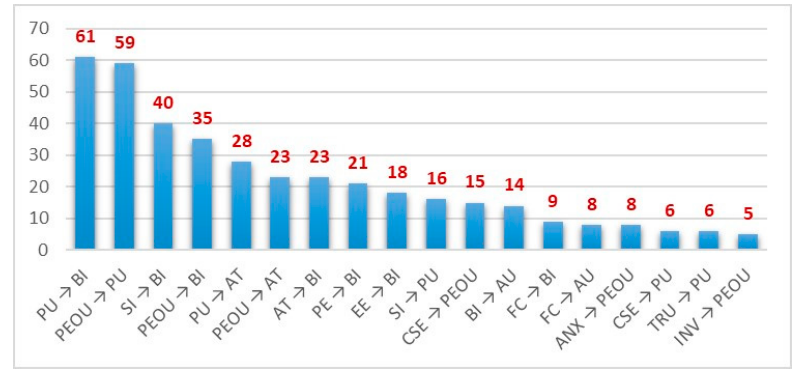
Figure 4. The most confirmed hypotheses in the reviewed